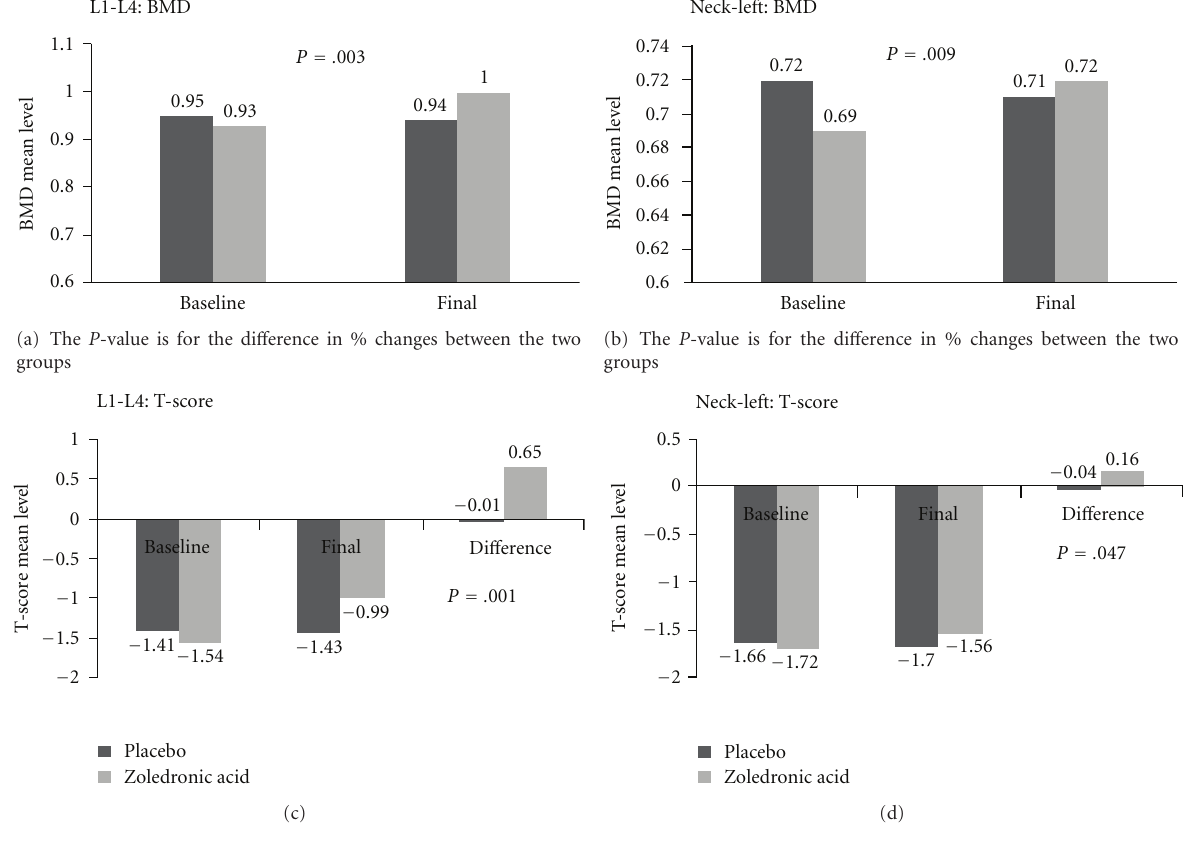
Figure 1: BMD and T-score measures at baseline and final.